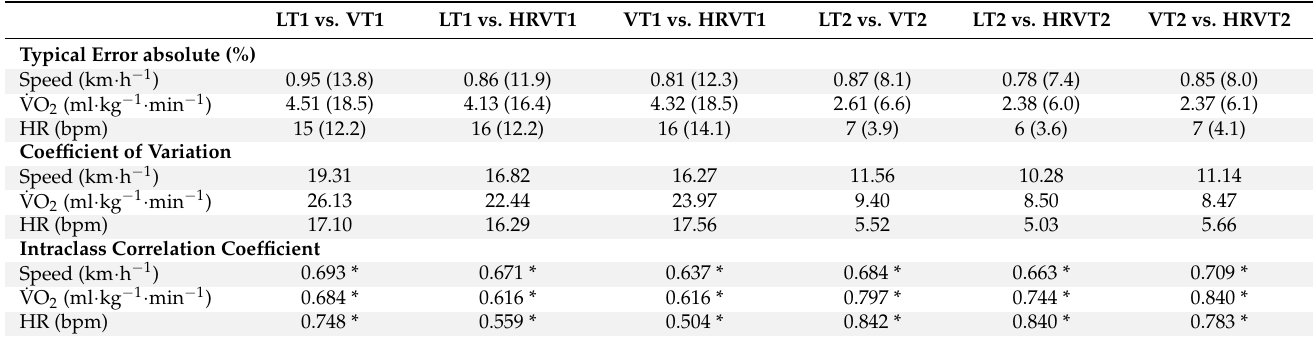
Table 4. Typical Error, Coefficient of Variation, and Intraclass Correlation Coefficient between the methods for identifying thresholds 1 and 2.